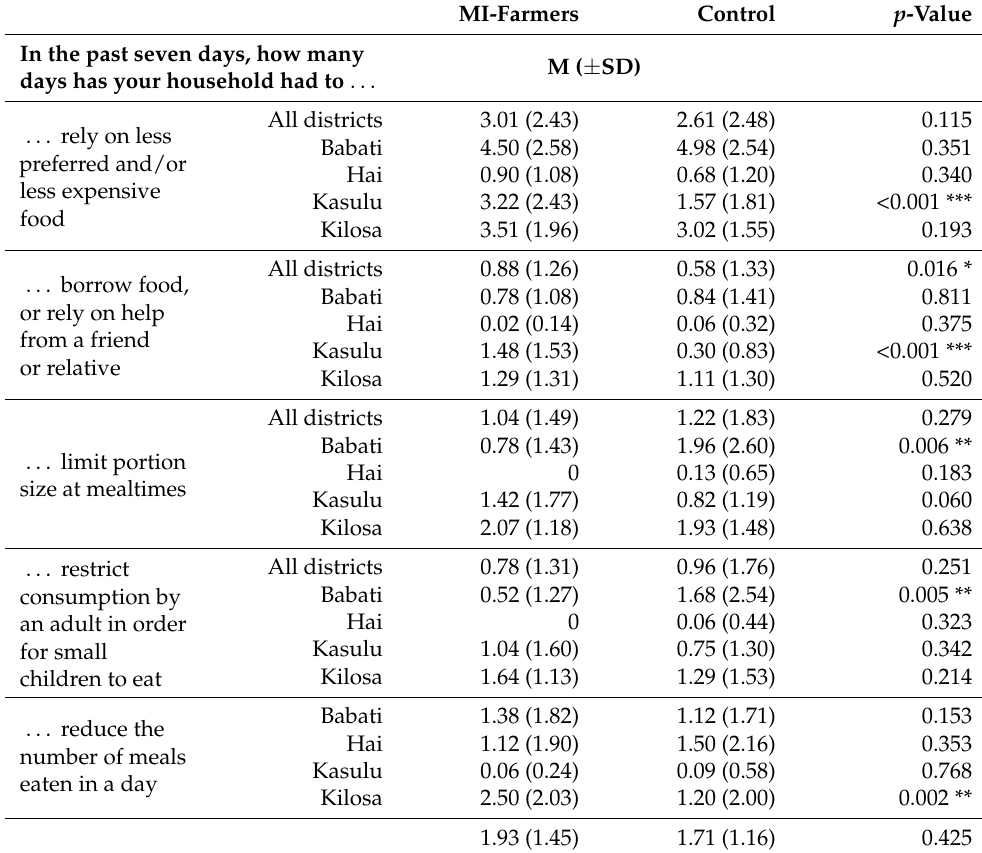
Table 6. Food security in MI and control households, measured using Reduced Coping Strategies Index